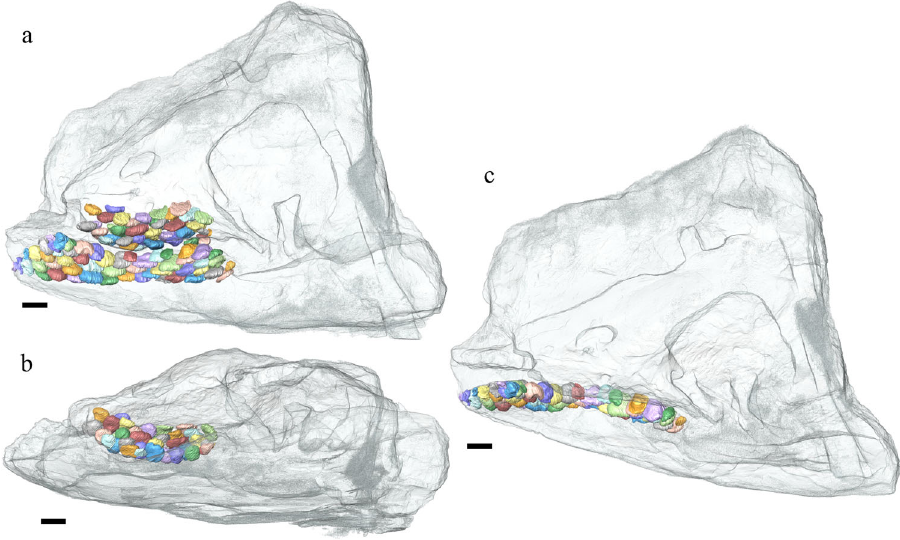
Fig. 5 CT reconstruction showing the tooth arrangement in Sclerocormus cf. S. parviceps (HFUT MJS-16-012). a Maxillary dentition and dentary dentition in left lateral view. b Maxillary dentition in ventral view. c Dentary dentition in dorsal view. Scale bars equal 1 cm. COMMUNICATIONS BIOLOGY| (2022) 5:1242